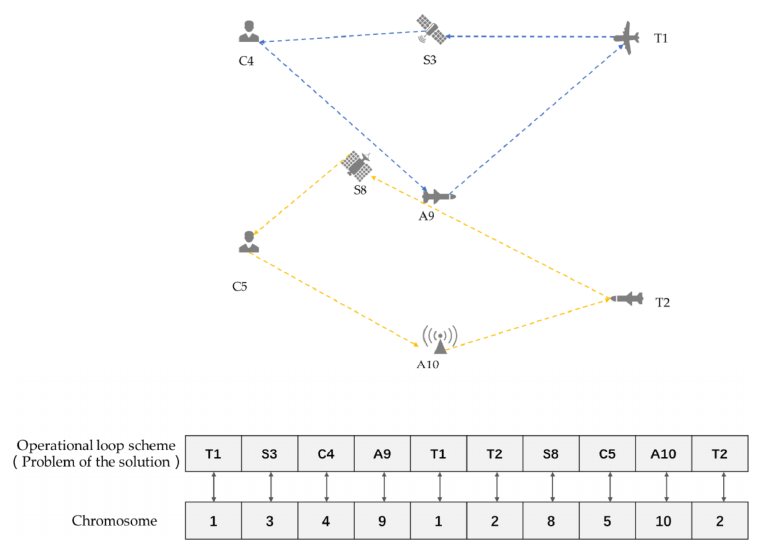
Figure 3. NSACGA-II algorithm framework.